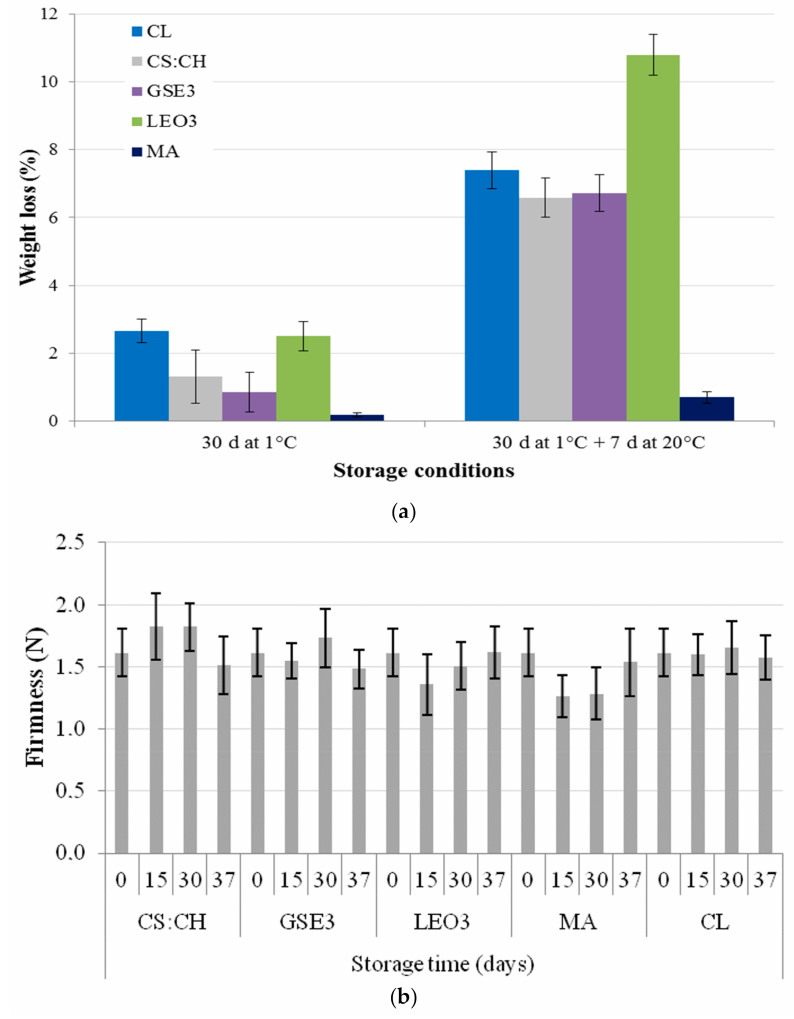
Figure 2. ( a ) Weight loss and ( b ) firmness of blueberries packed in clamshell (CL), biodegradable films based on corn starch and chitosan (CS:CH), active biodegradable films containing 3% grapefruit seed extract (GSE3) or 3% lemon essential oil (LEO3), and modified atmosphere commercial bags (MA). Blueberries were stored for 30 days under refrigeration conditions and then kept for 7 days at room